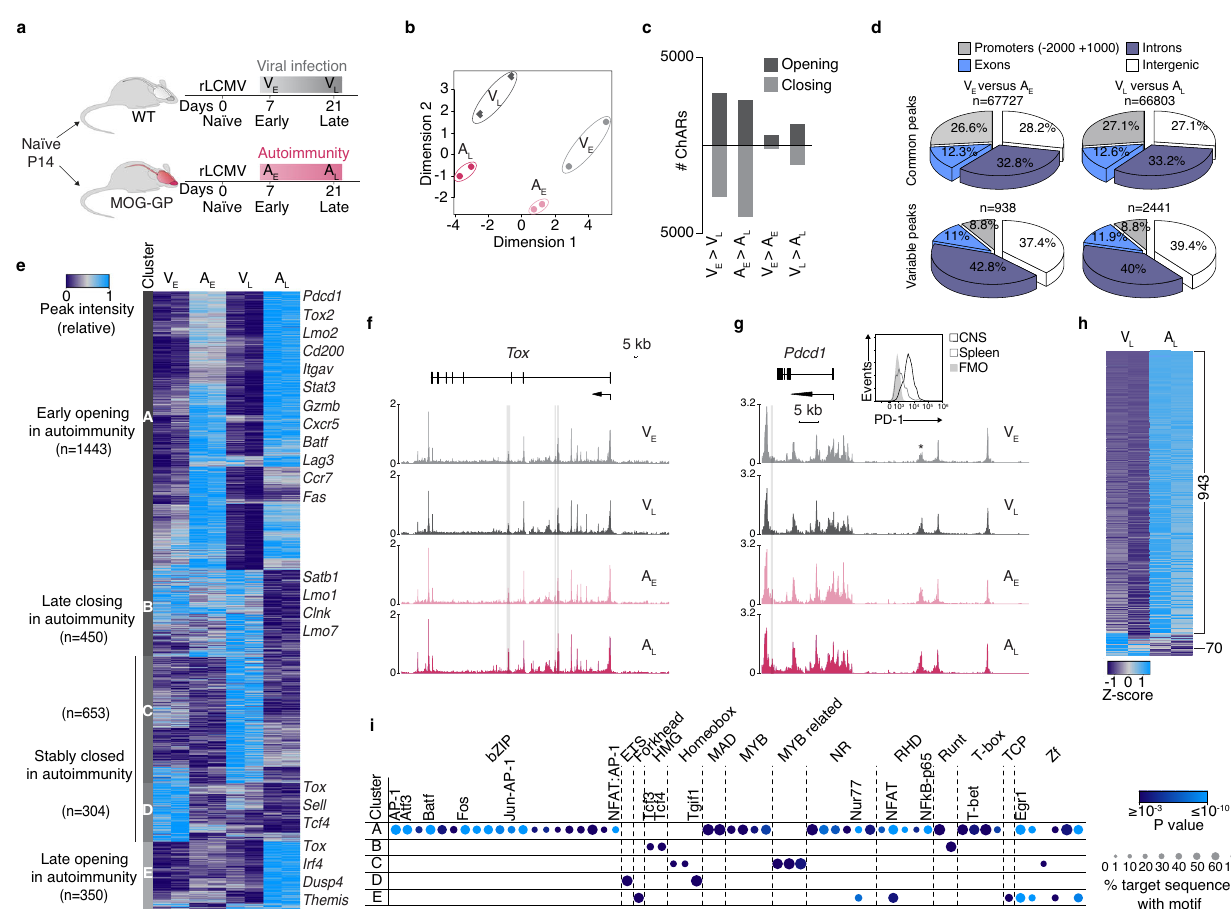
Fig. 1 Chromatin accessibility changes in self-reactive CD8 + T cells. 10 4 naive P14 cells were adoptively transferred into WT and MOG-GP mice. One day later (day 0), mice were challenged i.c. with 10 4 PFU rLCMV-GP33. Brain in fi ltrating P14 cells were submitted to ATAC-seq 7 and 21 days after i.c. infection. a Experimental scheme. V E and V L (viral infection early and late) correspond to brain in fi ltrating P14 cells isolated from WT mice (gray) at early (day 7) or late time point (day 21) after i.c. infection. A E and A L (autoimmunity early and late) correspond to brain in fi ltrating P14 cells isolated from MOG- GP mice (pink) at early (day 7) or late time point (day 21) after i.c. infection. b Multidimensional scaling (MDS) plot of chromatin accessibility from A E , V E , A L , and V L P14 cells. Similarity of chromatin accessibility is proportional to the distance between samples. c Number of differentially accessible ChARs in each different comparison (Log 2 FC ≥ 1; FDR < 0.05). d Pie charts showing the distribution for common and variably accessible peaks within promoters, exons, introns, and intergenic regions in the comparisons (V E vs. A E ) and (V L vs. A L ). Variable peaks: (Log 2 FC ≥ 1; FDR < 0.05). e Heatmap of the normalized peak intensity for ChARs displaying differential accessibility in at least one of the comparisons (V E vs. A E ) or (V L vs. A L ) (Log 2 FC ≥ 1; FDR < 0.05). Hierarchical clustering indicates grouping of samples by ChARs behavior during CNS autoimmunity. Key genes proximal to loci with differential accessibility are indicated for each cluster. Each column represents a biological replicate. f ATAC-seq track of Tox locus for V E , V L , A E , and A L . Differentially accessible ChARs (FDR < 0.05) are highlighted in gray. g ATAC-seq tracks of Pdcd1 locus for V E , V L , A E , and A L . Asterisk corresponds to the exhaustion- speci fi c enhancer at − 23.8 kb of the TSS. Differentially accessible ChAR (FDR < 0.05) is highlighted in gray. Representative fl ow cytometry histogram of PD-1 expression in splenic and brain in fi ltrating P14 cells isolate from WT mice after rLCMV-GP33 i.c. infection (day 21). h ATAC-seq Z-score of signi fi cantly differentially accessible ChARs (FDR < 0.05) at exhaustion-associated regions 33 . i Enrichment of all known transcription factor (TF) motifs within each cluster of differentially accessible ChARs as de fi ned in ( e ). Color depicts the signi fi cance of motif enrichment (hypergeometric test) and circle size indicates the fraction of sequence containing a speci fi c motif. All motifs with an enrichment p-value below 10 − 3 in at least one cluster are shown. Source data are provided as a Source data fi